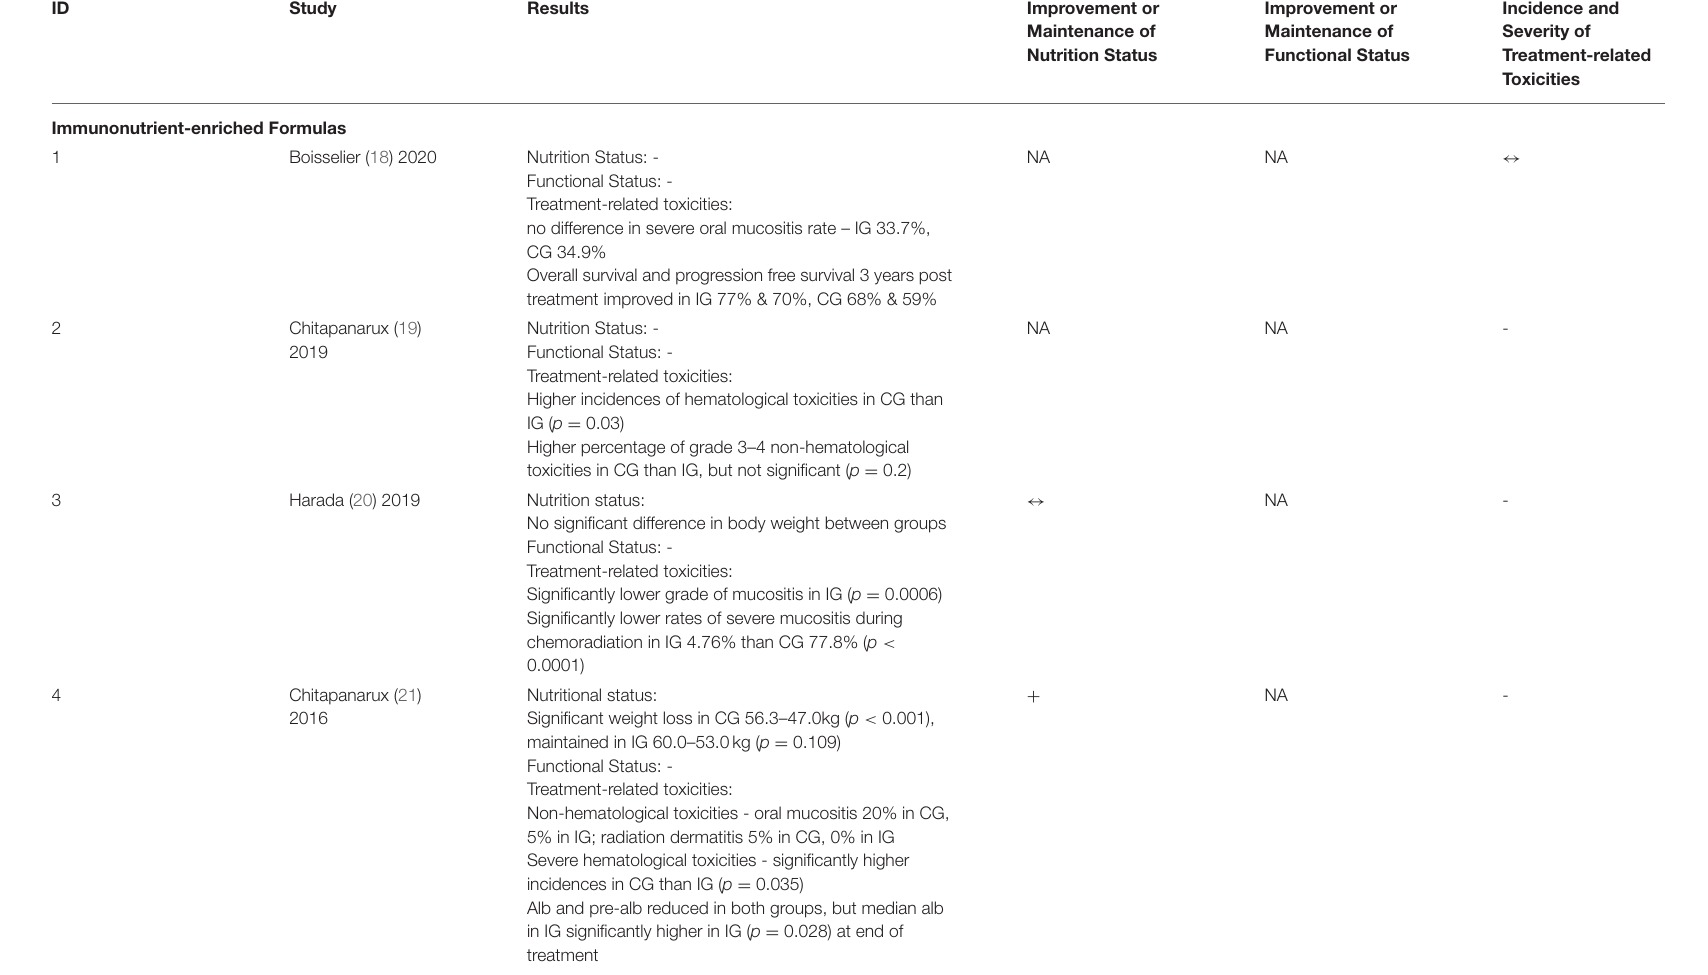
TABLE 4 | Summary of